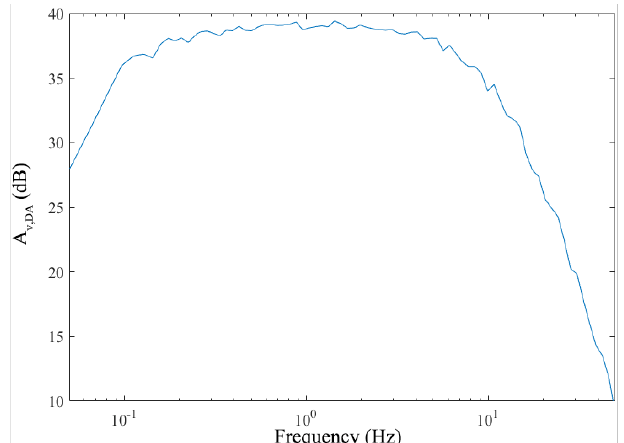
Figure 11. The measured frequency response of A v , DA